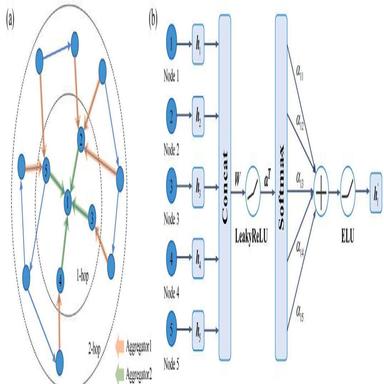
Illustration of (a) messaging based on the neighbour sampling strategy, and (b) aggregation approach based on dynamic attention mechanism.